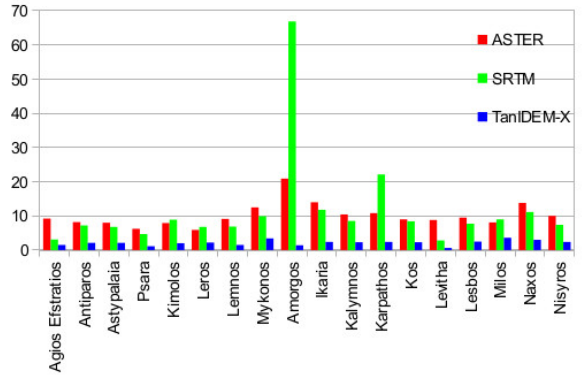
Figure 11. RMSE (m) of the global DEMs with respect to local elevation data. (DX,DY,DZ) as shown in Tables 5,